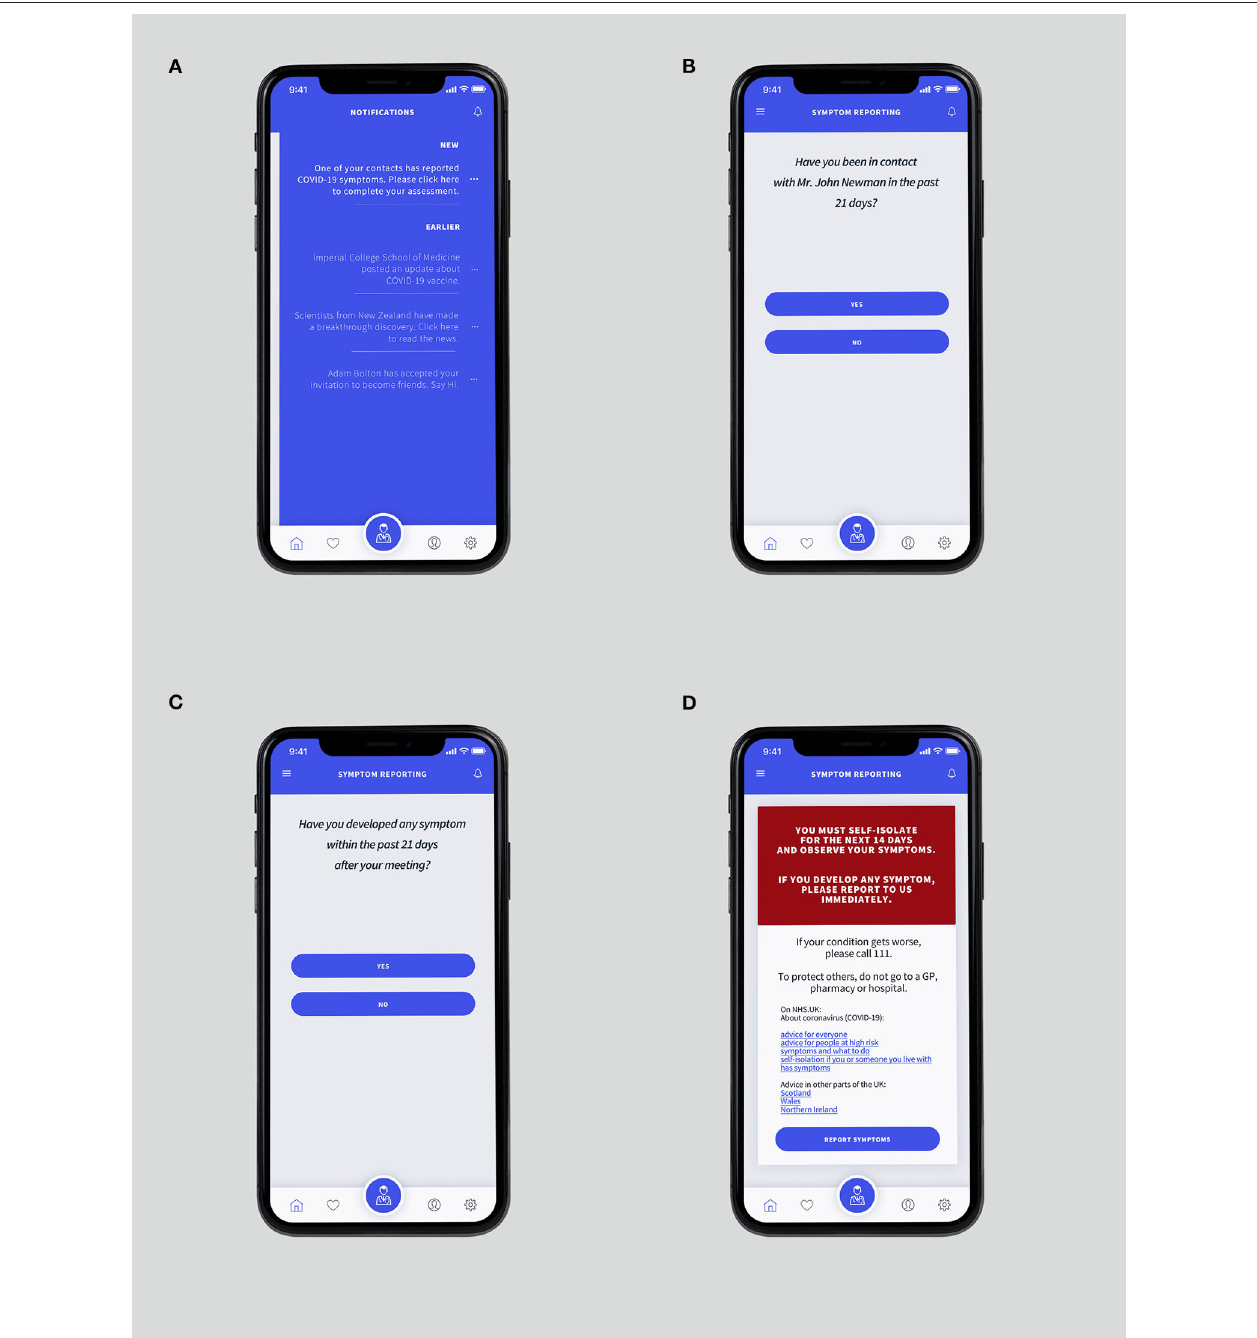
FIGURE 9 | (A) The “Notification Panel” which can be accessed by swiping the screen from the right-hand side. (B) “Suspected” recipient is requested whether the user has been in contact with Mr. John Newman, who recently reported COVID-19 symptoms. (C) The verifier ensures whether the “suspected” developed any symptom after the meeting. (D) The confirmation page is showing details of instructions if suspicion is confirmed.